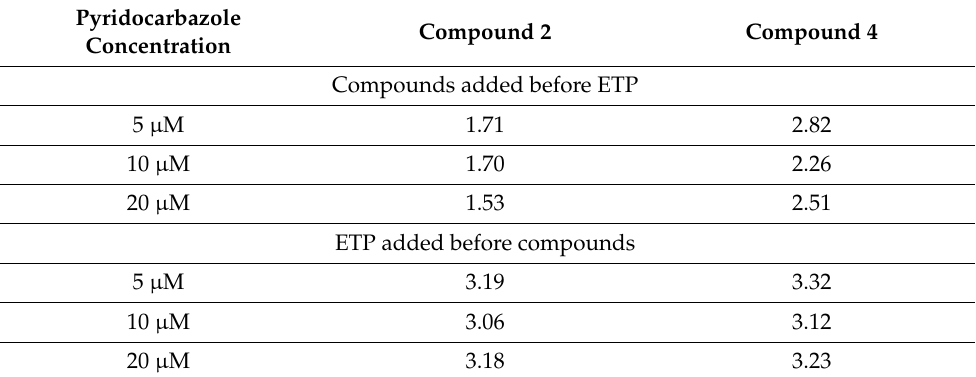
Table 2. Evaluation of genotoxic effects of the tested compounds compared to ETP (for average ETP concentration from the range 5–10 µ M, which was 7.5 µ M). The result was expressed as the proportion to the ETP caused damage in three tests, where the reference value for etoposide is E ETP = 3. Pyridocarbazole